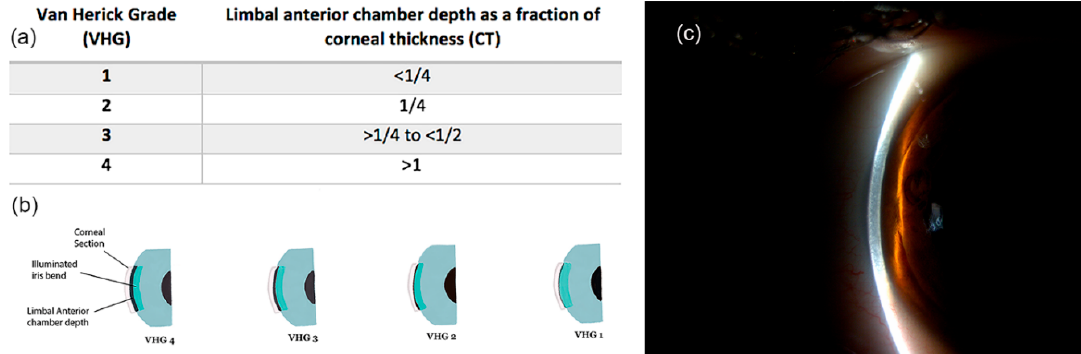
Figure 4. Limbal anterior chamber depth measurement using traditional Van Herick grading (VHG) system. ( a , b ) Table and illustration of the traditional 4-point Van Herick grading scheme; ( c ) Slit-lamp image of LACDM.